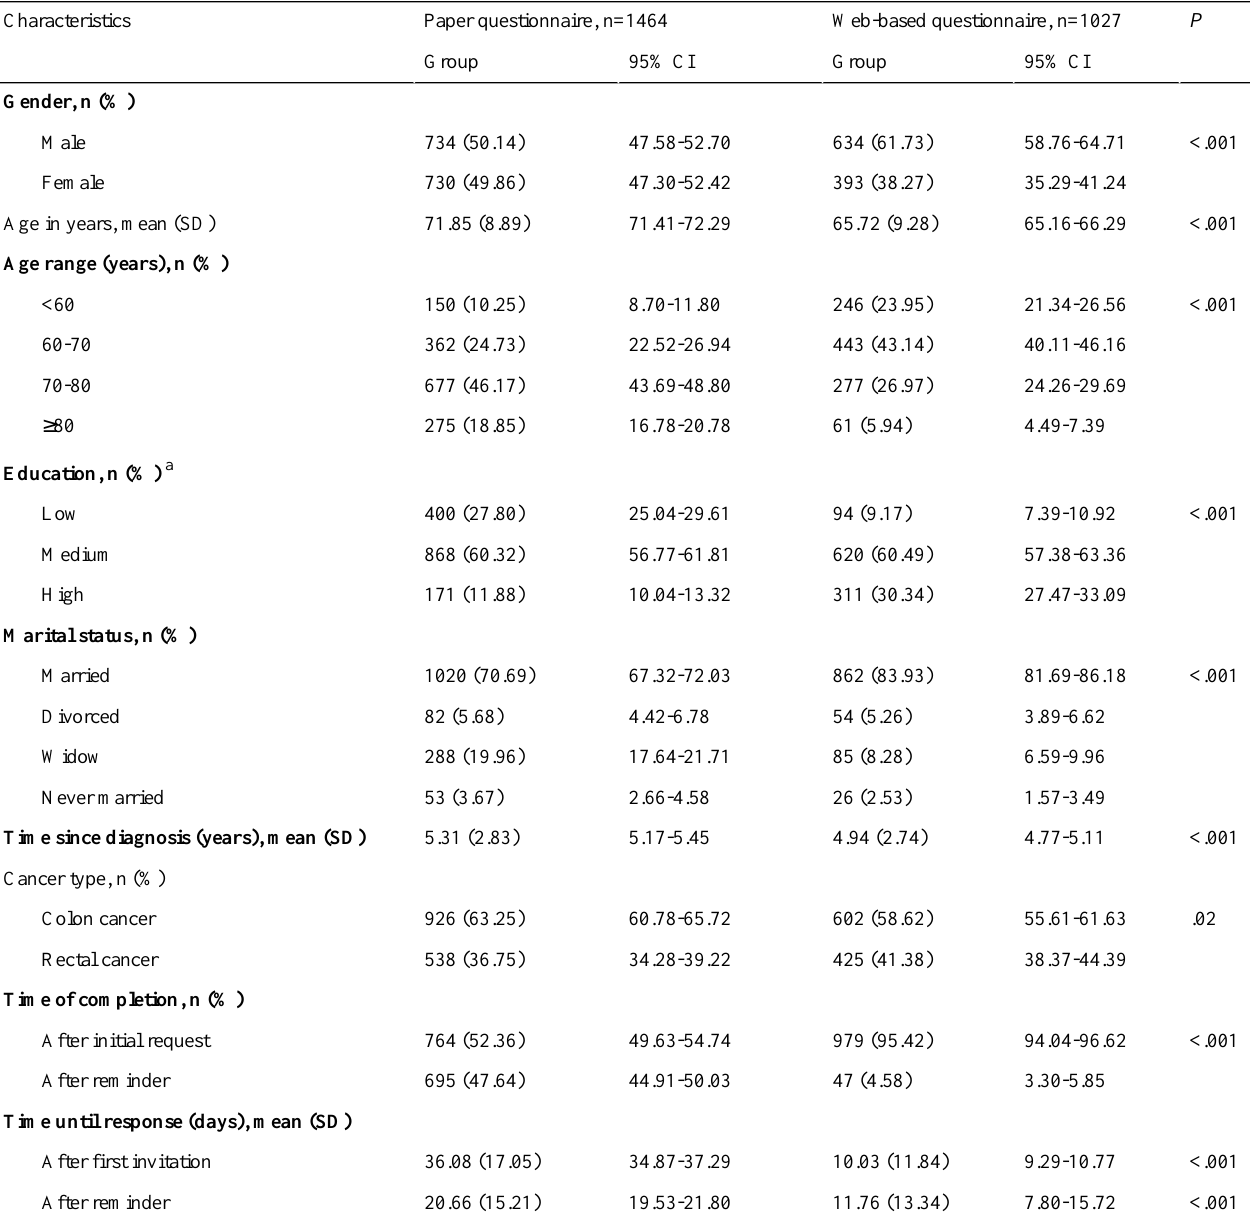
Table 3. Demographic and clinical characteristics of colorectal cancer patients in the paper-optional group stratified by questionnaire type used.